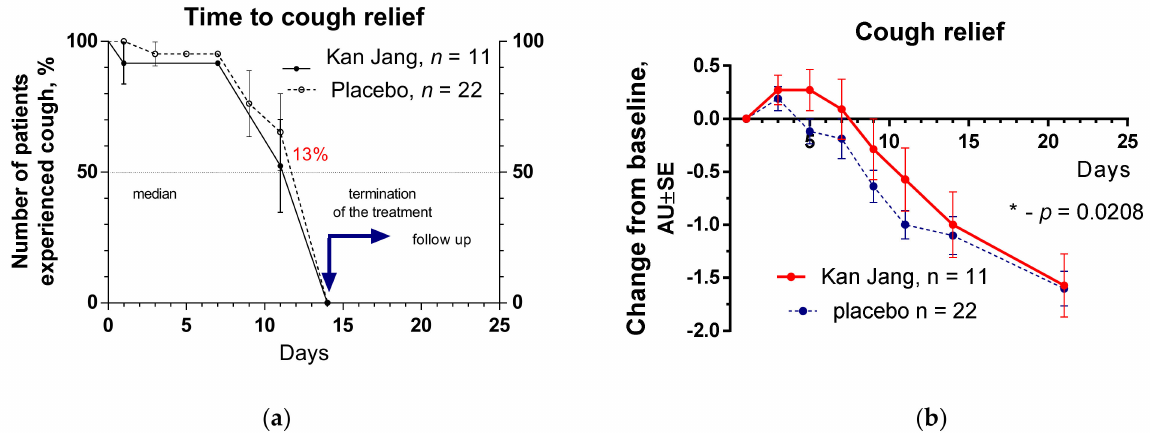
Figure 7. ( a ) Time to cough relief in the treatment and control groups. Kaplan–Meier curves show the percent of patients with muscle pain over the time from randomization (Day 1) to the end of the treatment (Day 14) and follow-up for one week (Day 21); median recovery: Kan Jang ® was 9 days, placebo was 11 days; hazard ratio Kan Jang/placebo = 1.345, 95% CI of ratio from 0.4683 to 3.863. ( b ) The changes in the severity of the cough from the baseline of patients in group A (Kan Jang) and group B (placebo) over the time from Day 1 to Day 21. Between-groups comparison of the changes in the severity of the symptom from the baseline over time shows significant interaction ( p < 0.0001). The Kan Jang ® treatment has a statistically significant effect on cough compared to the placebo. *— p < 0.05.